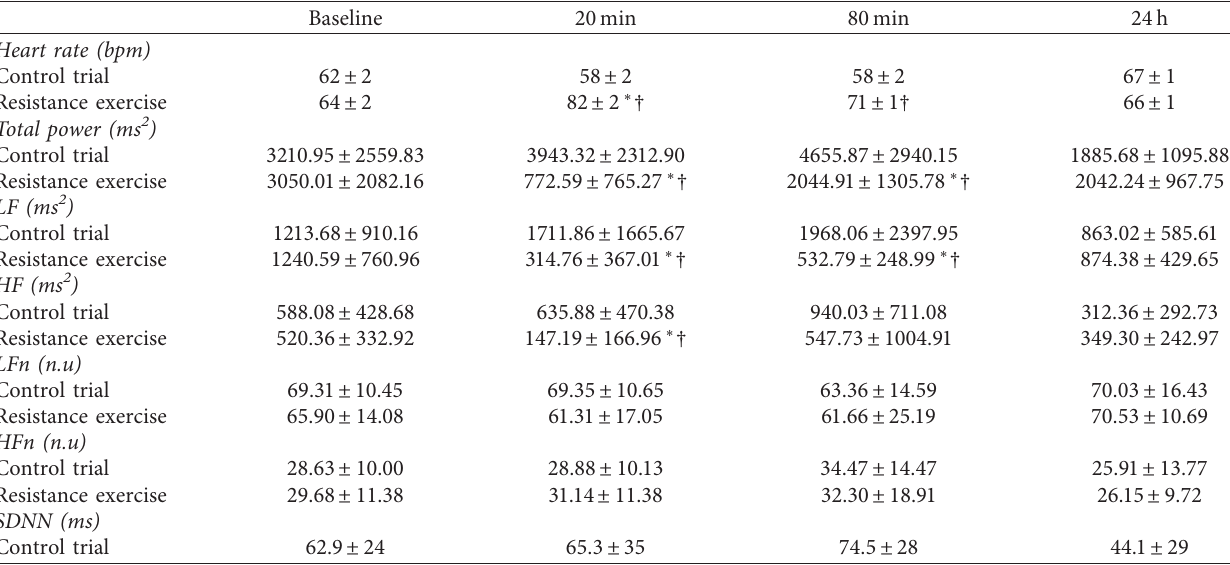
Table 2: Spectral analysis of the heart rate variability before and after RE and CTR